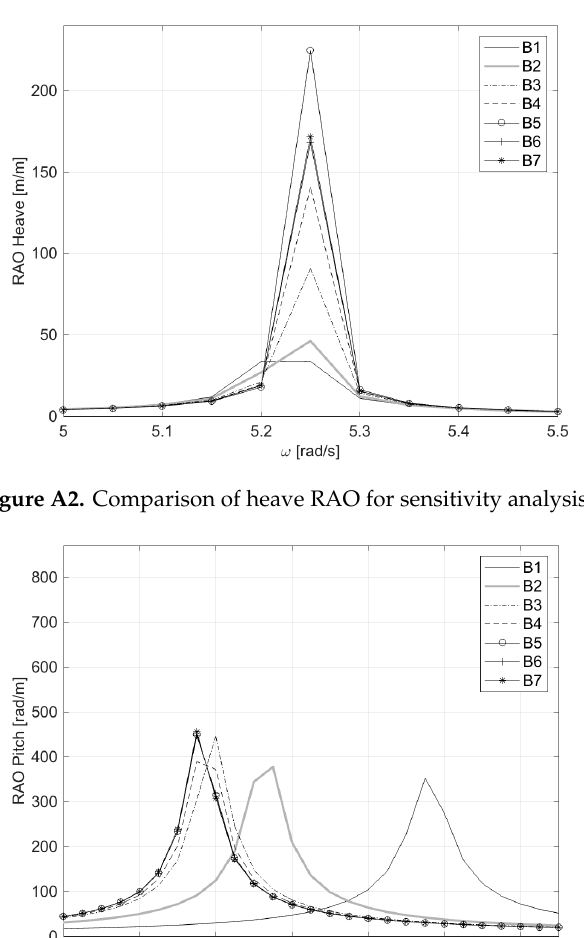
Figure A1. Comparison of surge RAO for sensitivity analysis.